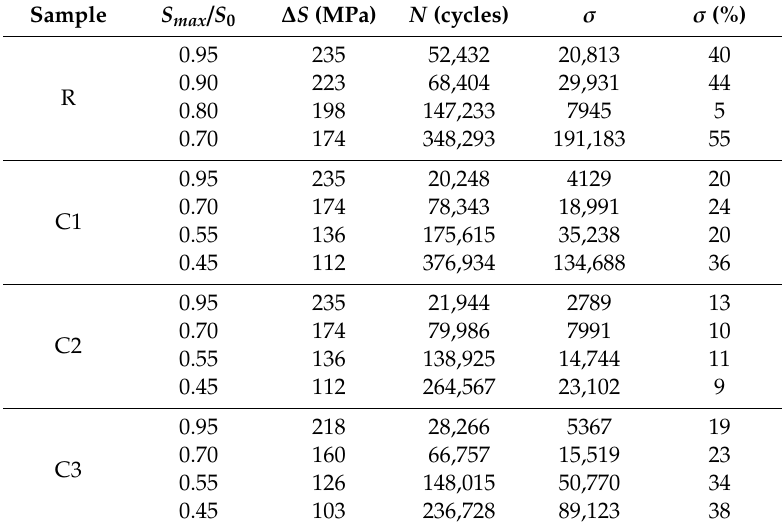
Figure 7. Stress range ( ∆ S ) vs. average number of cycles at failure ( N ) curve. Table 3. Data of stress range ( ∆ S ) and average number of cycles at failure ( N ) for S max / S 0 ratios tested. σ is the standard deviation of N data and (% σ ) standard deviation expressed as percentage.